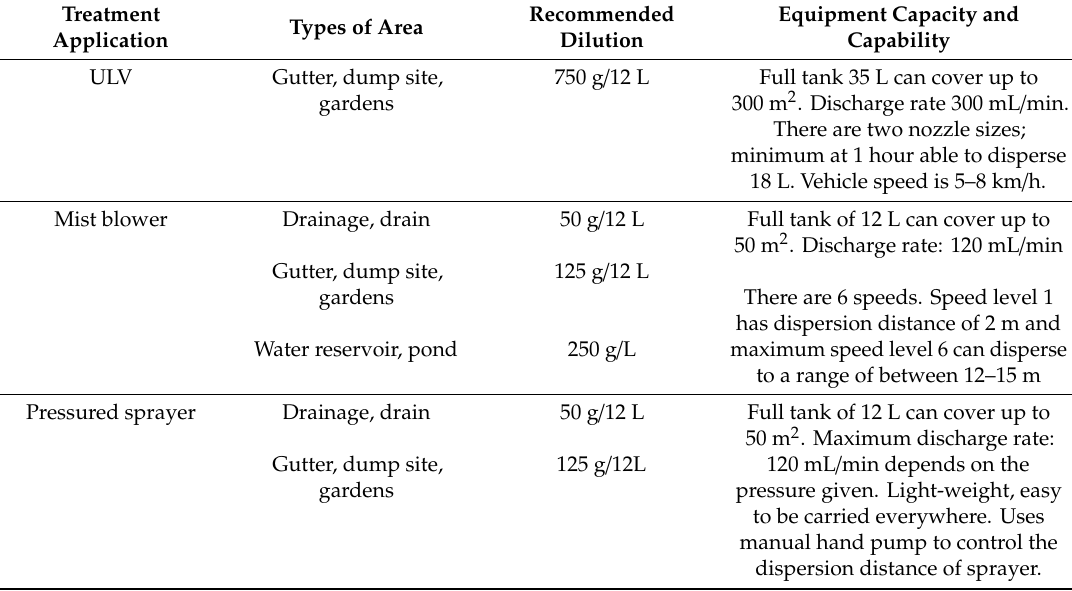
Table 2. The specification of treatment applications used in this